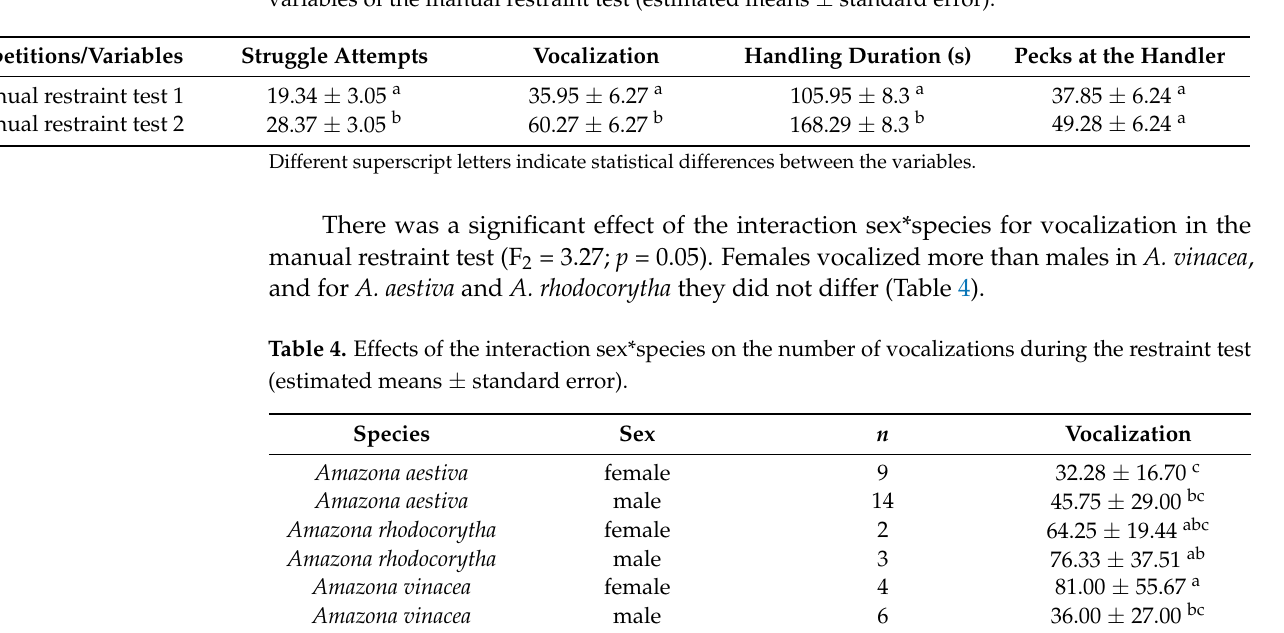
Table 3. Effect of evaluation (before and after the flight and human aversion training protocol) on the variables of the manual restraint test (estimated means ± standard error).